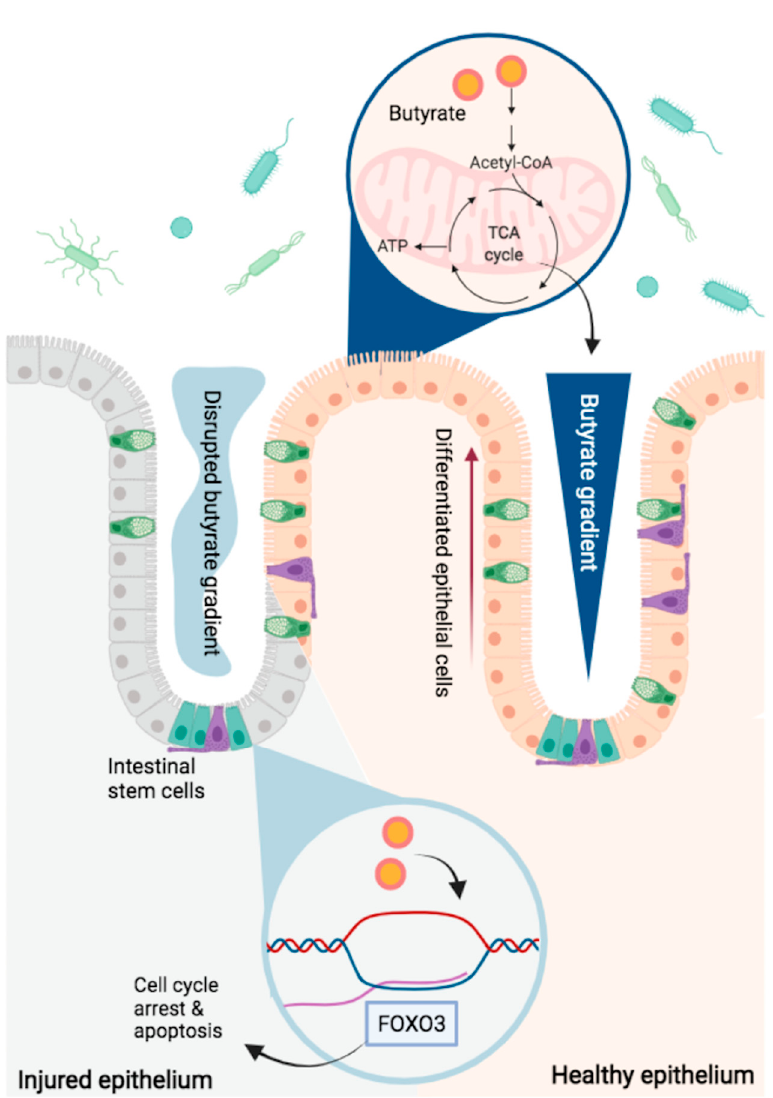
Figure 2. The epithelial crypt in mice facilitates production of a butyrate gradient which is necessary to maintain the proliferative potential of intestinal stem cells. Butyrate is an abundant energy source for surface level epithelial cells in the mammalian intestine. Rapid intracellular transport and oxidation by these cells produces a butyrate gradient, with significant depletion of butyrate levels at the crypt base. Disrupted crypt morphology, as in the case of mucosal injury, allows butyrate levels to rise at the crypt base, where it induces antiproliferative activity in intestinal stem cells, mediated by the transcription factor Foxo3.